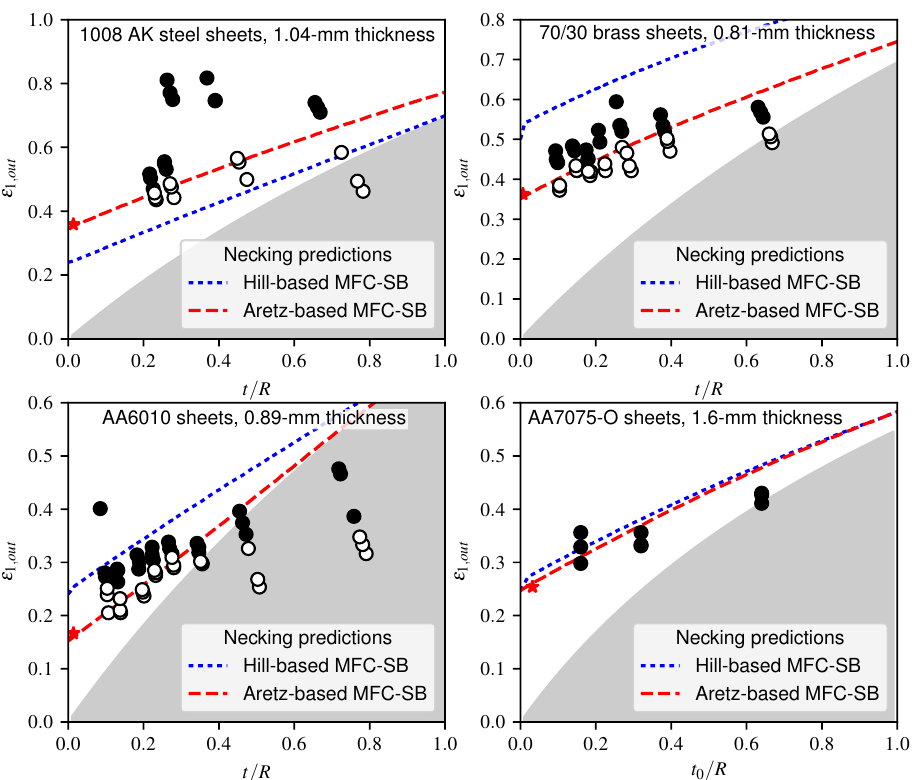
Figure 6. Necking predictions of the proposed maximum force criterion in stretch-bending